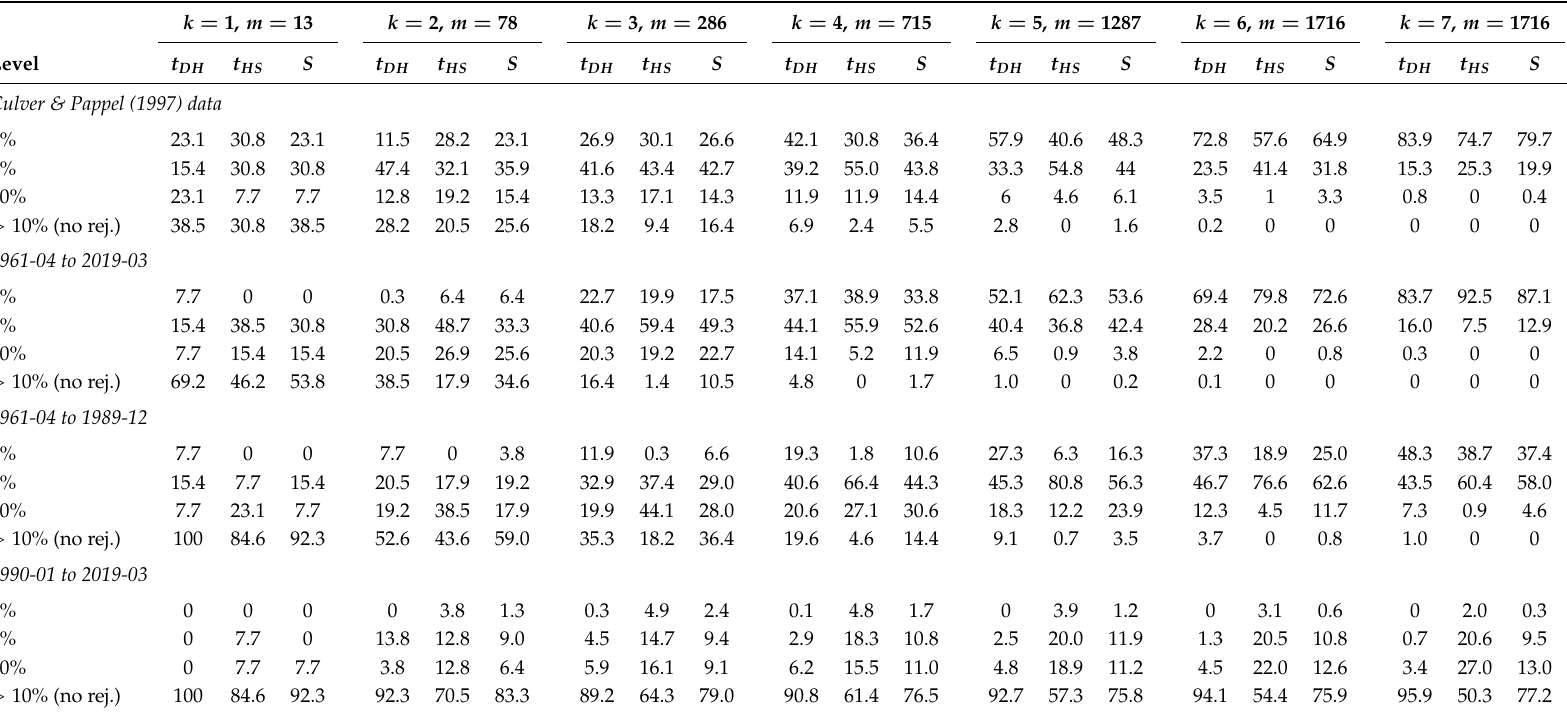
Table 3. Robust testing for unit roots in inflation rates of OECD countries—all combinations. Economies: Belgium, Canada, Germany, Spain, Finland, France, the United Kingdom, Italy, Japan, Luxemburg, the Netherlands, Norway, and the United States. Inflation rates are computed as differences in logarithms of CPIs. ) subsets of k countries. For prewhitening, the maximum optimal lag order is determined using the Entries are proportions of rejection of m = ( 13 k